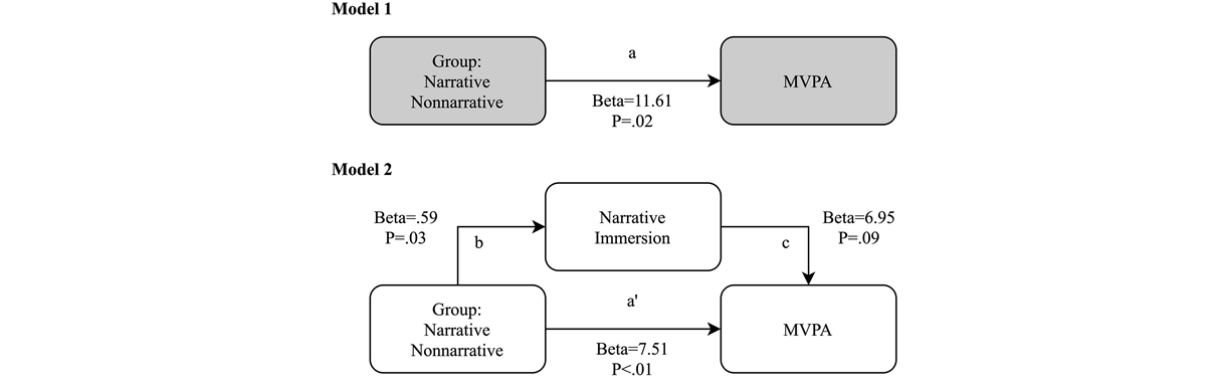
Figure 3. Mediation model of the relationship between narrative immersion and minutes in moderate-to-vigorous physical activity during active video game play. MVPA: moderate-to-vigorous physical